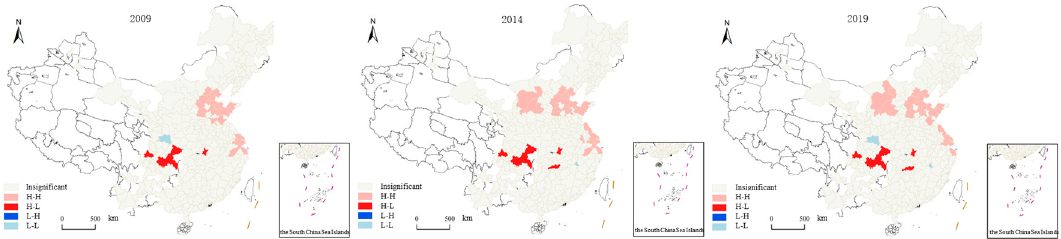
Figure 3. LISA aggregation map of transportation carbon emissions in characteristic years.